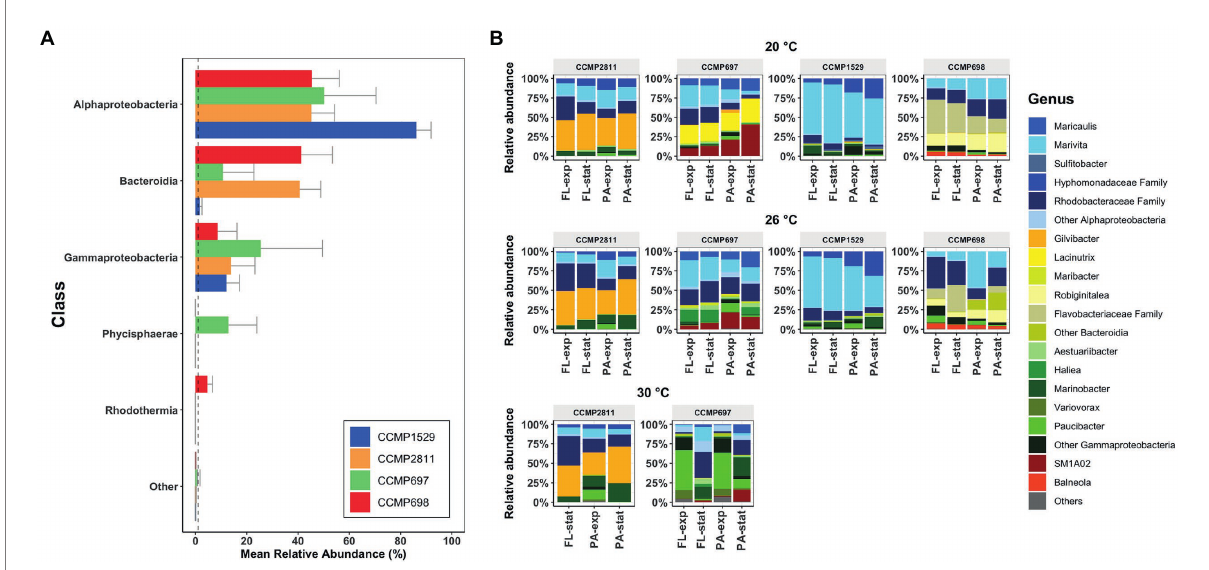
FIGURE 3 Composition of the bacterial communities of Prorocentrum cordatum xenic cultures. (A) Mean relative abundance of the bacteria (Class level) found in each P. cordatum strain. ASVs with an overall abundance below 1% are listed as “Others.” Dashed line indicates the 1% threshold. (B) Mean relative abundance of bacterial genera found in each P. cordatum strain at each temperature. Samples are grouped by triplicates and listed by lifestyle and growth phase. Colors represent bacterial genus level, where shades of blue correspond to genera from the class of Alphaproteobacteria, shades of yellow to Bacteroidia, shades of greens to Gammaproteobacteria, red to Phycisphaerae, and orange to